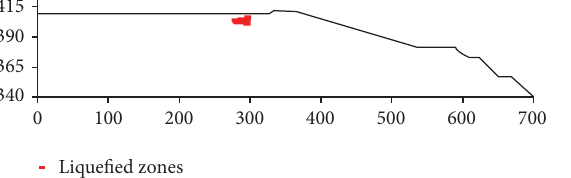
Figure 14: Potential liquefied zones after shaking with extreme earthquake. Dimensions are in meters. For visibility, scale of vertical axis is larger than the horizontal axis.